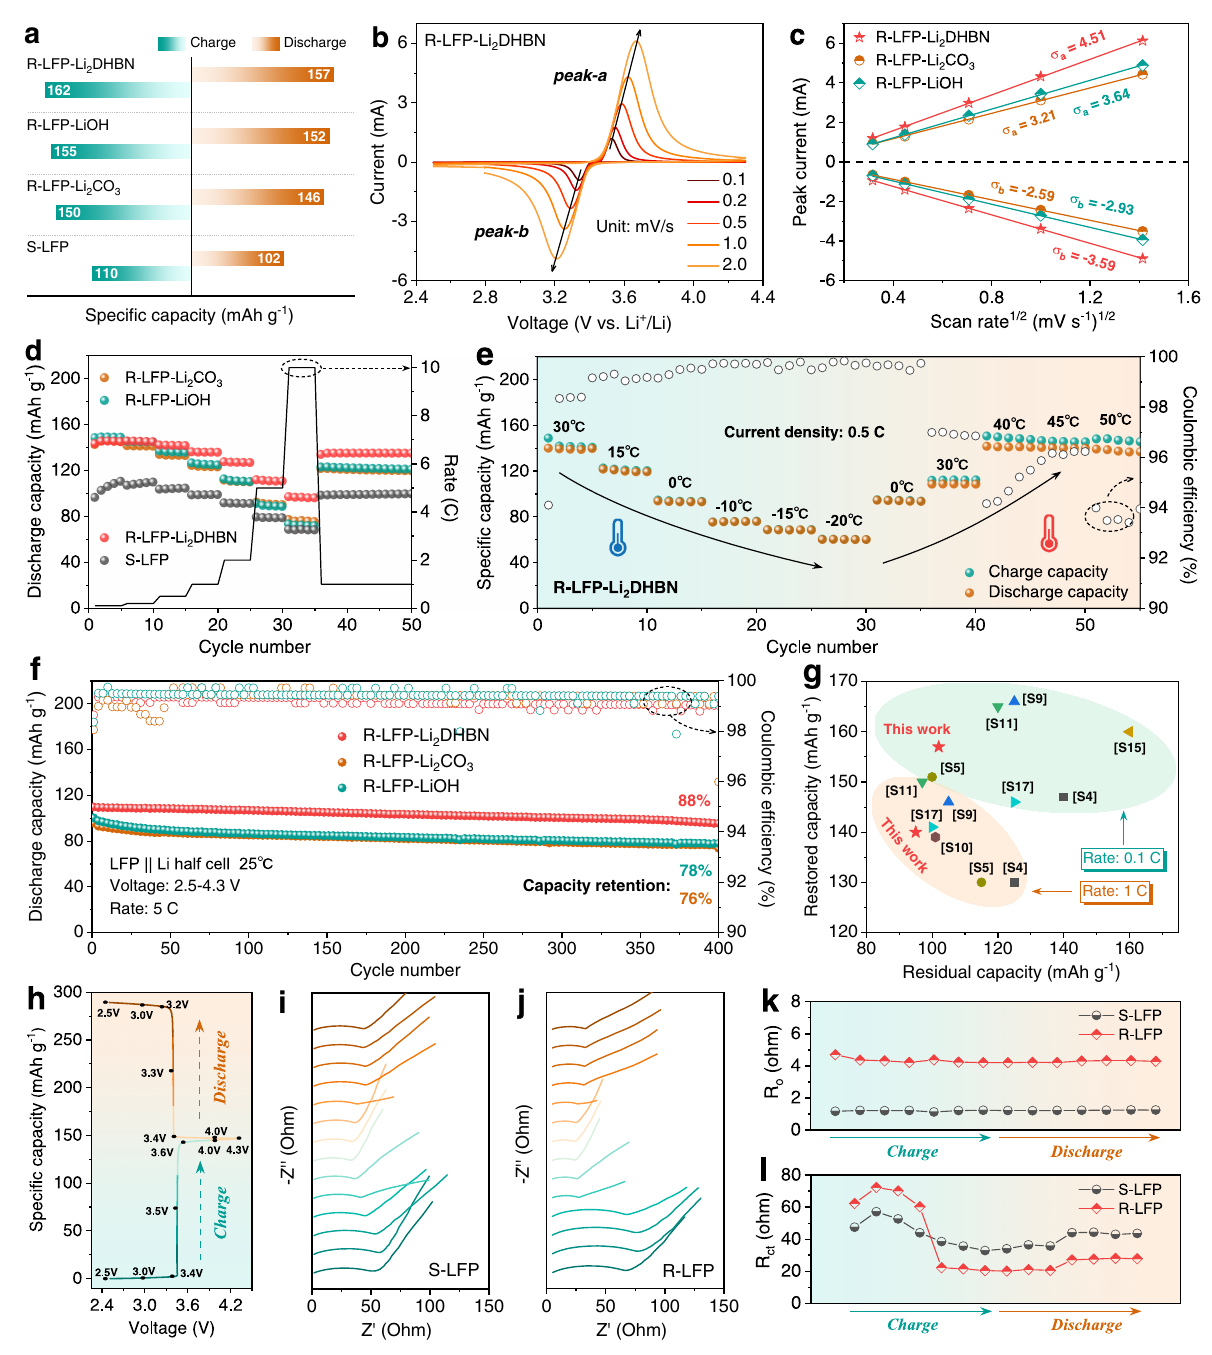
Fig. 3 | Electrochemical performance and kinetics of LFP cathodes. a The resi- dual and restored capacityat0.1C. b CVcurves ofR-LFP-Li 2 DHBNatdifferent scan rates. c Linearrelationship between the major peakcurrents and scanrates. d Rate performance of S-LFP and R-LFP. e High-and-low temperature performance of R-